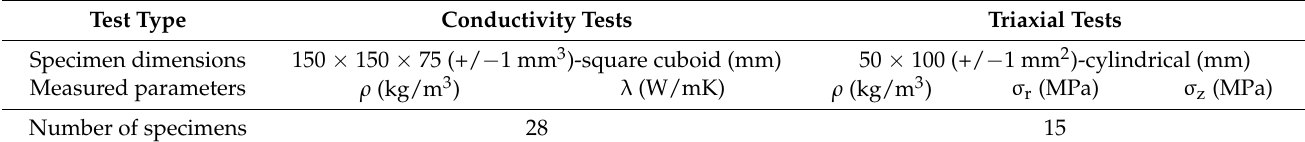
Table 2. Overview of the experimental